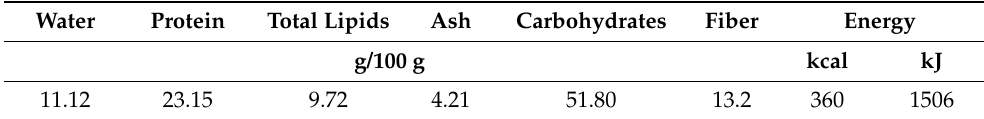
Table 1. Nutrients content of wheat